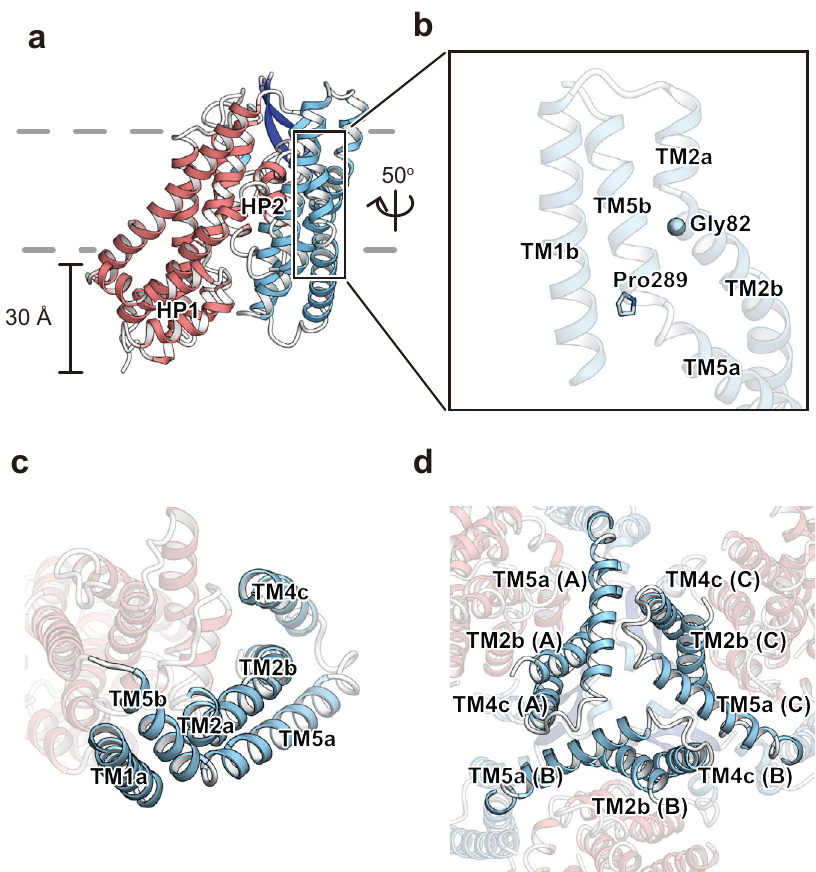
Fig. 2 | Protomer structure of HsEAAT2. a Overall structure of the HsEAAT2 protomer, as viewed from the membrane plane. The distance indicates the pro- trusion of the transport domain from the lipid membrane. b The “ kink-inducing ”